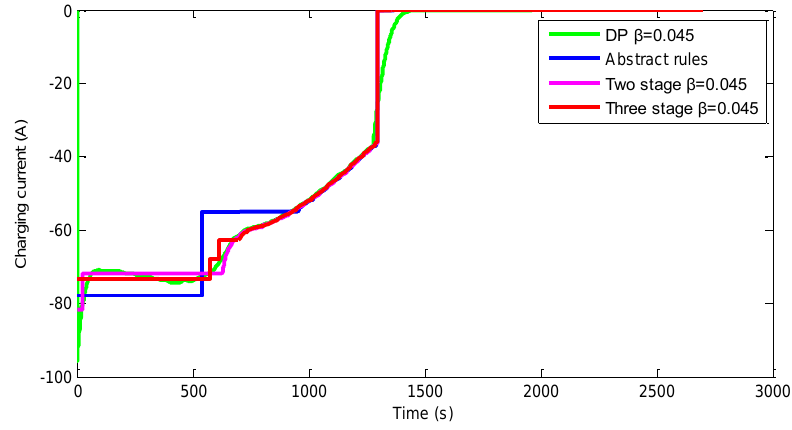
Figure 11. The charging current comparison of the three different